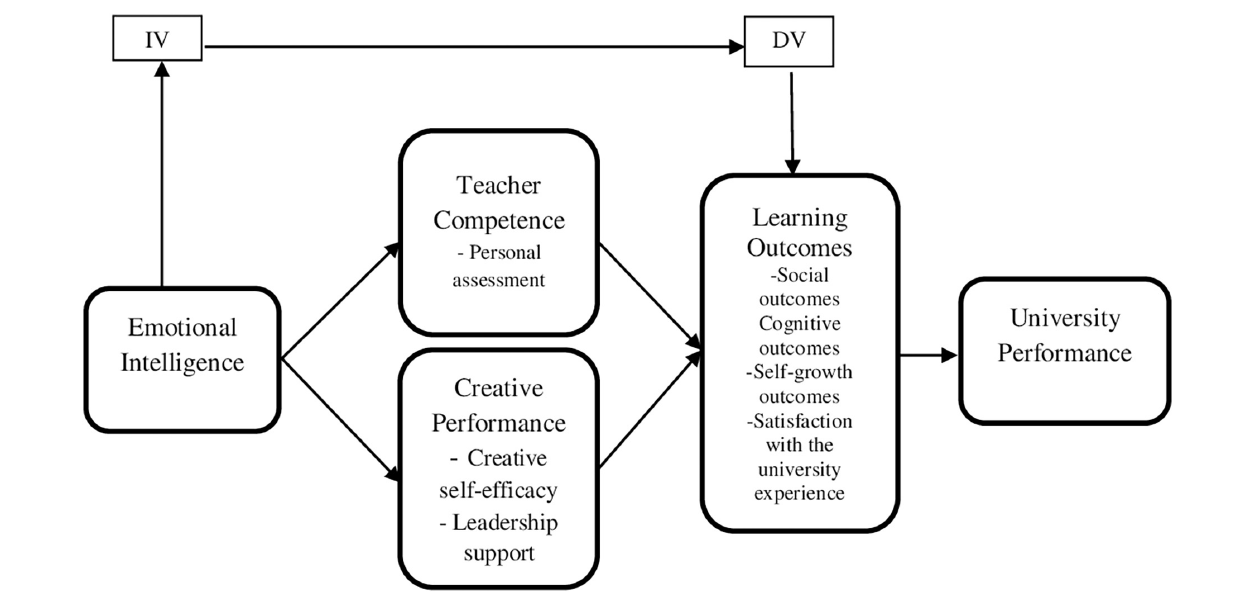
FIGURE 1 | Conceptual